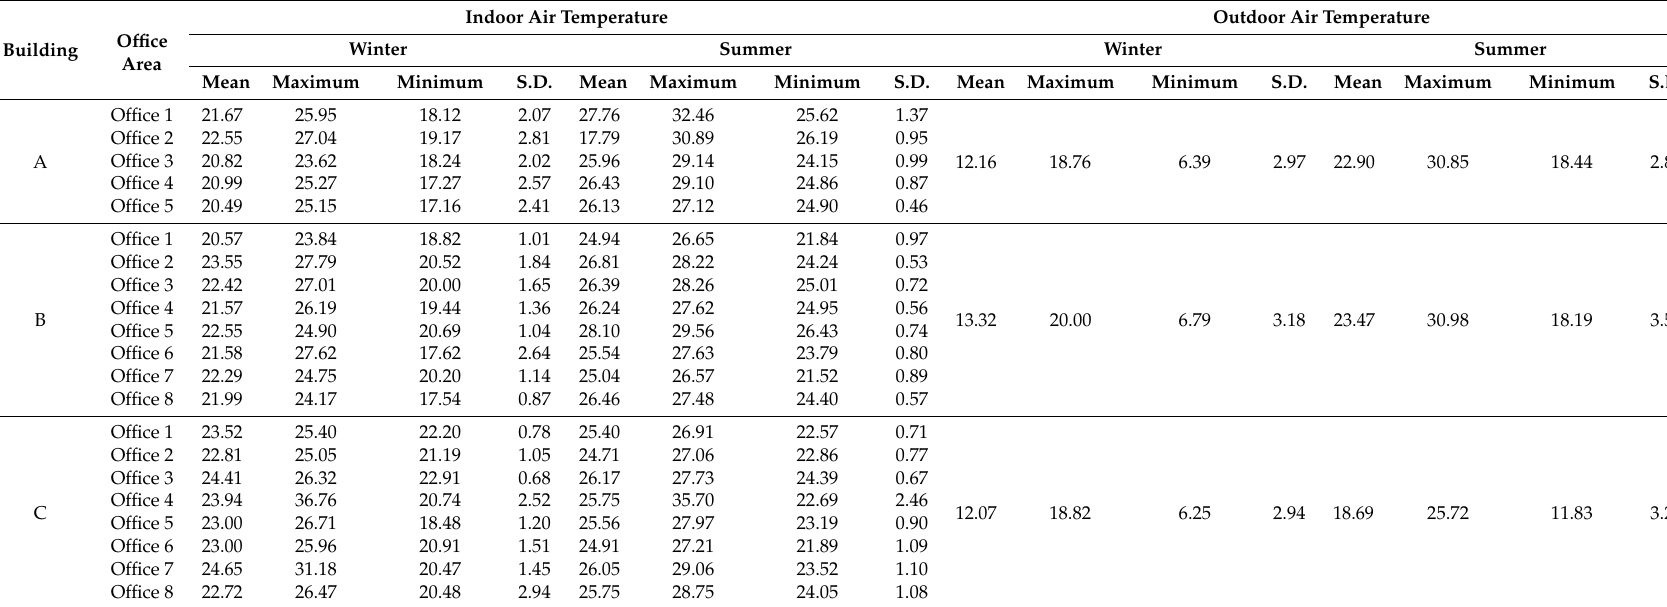
Table 5. Results of the in-situ measurements regarding indoor and outdoor air temperature during winter and summer period, per